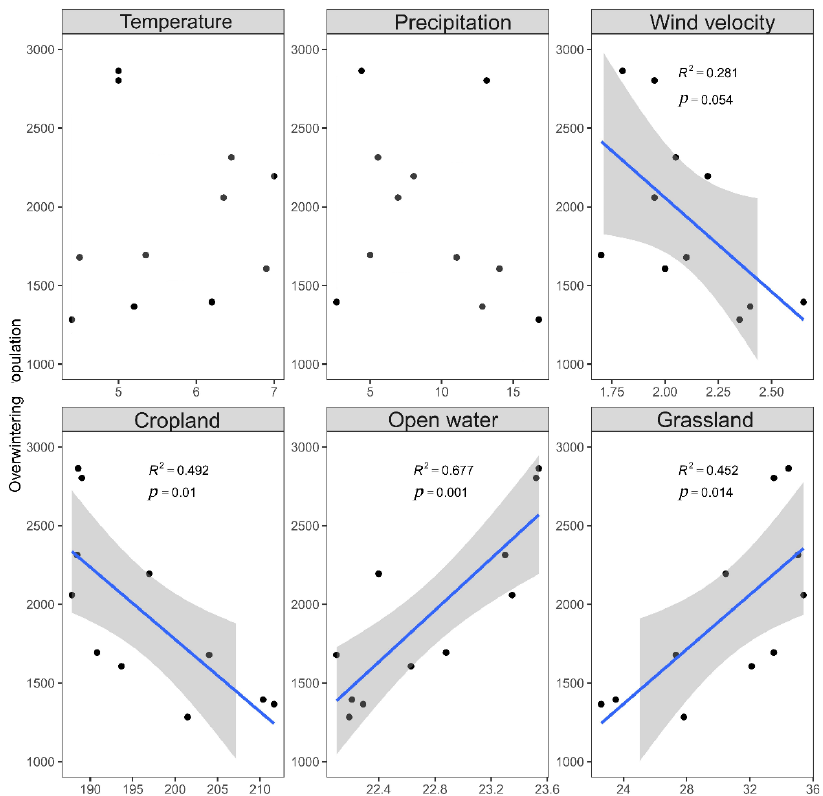
Figure 4. The effect of Cropland, Grassland, Precipitation, Temperature, Open water, and Wind velocity on wintering population size of bar-headed geese over 11